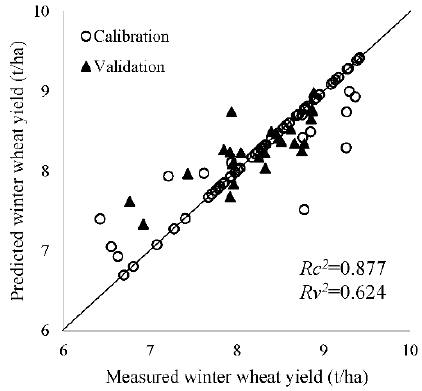
Figure 10. Calibration and validation of winter wheat yield prediction based on the weighted characteristic spectral information.